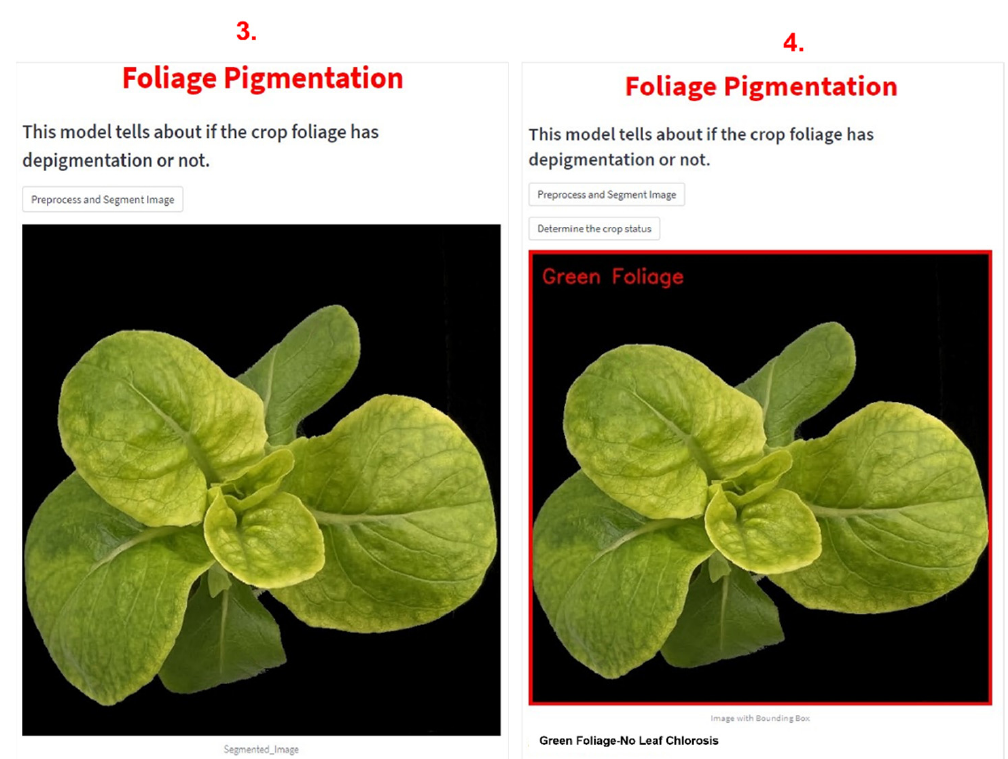
Figure A3. Stage 5 of cloud-based application. Figure A2. Stages 3 and 4 of cloud-based